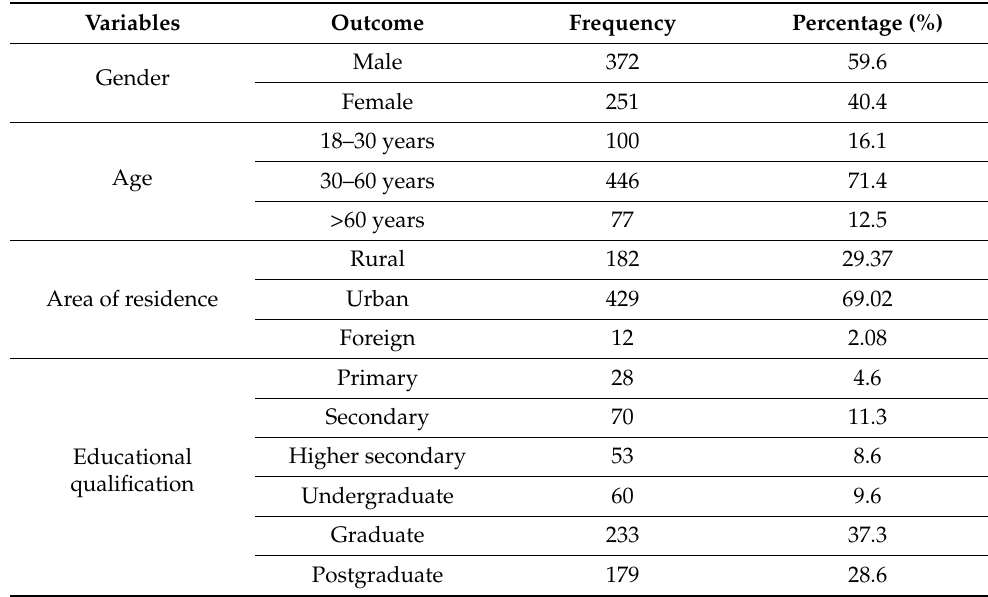
Table 1. Demographic data of the vaccinated population from a random and cross-sectional study in Bangladesh ( n =